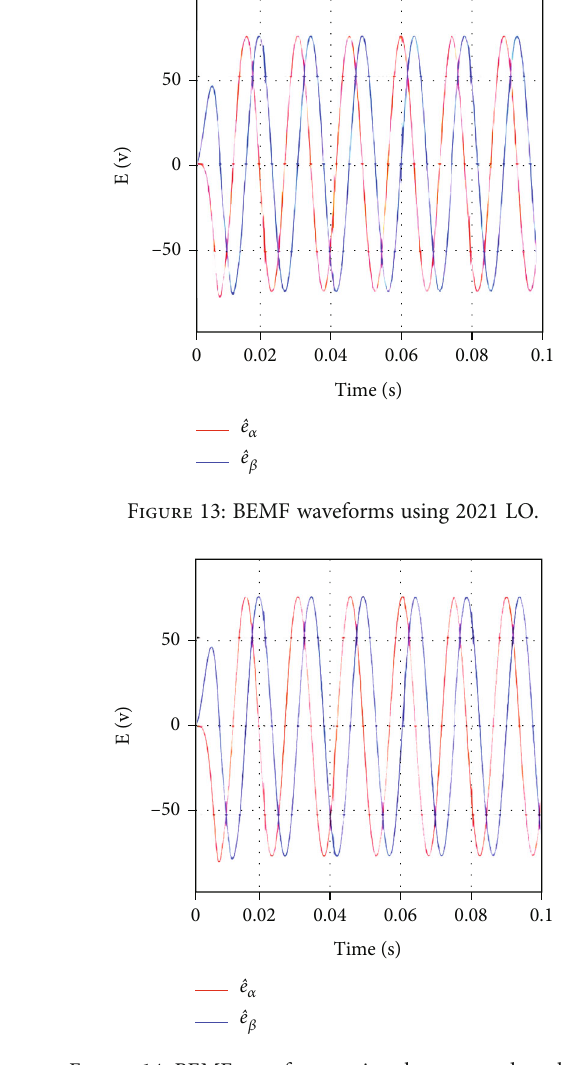
Figure 14: BEMF waveforms using the proposed method.